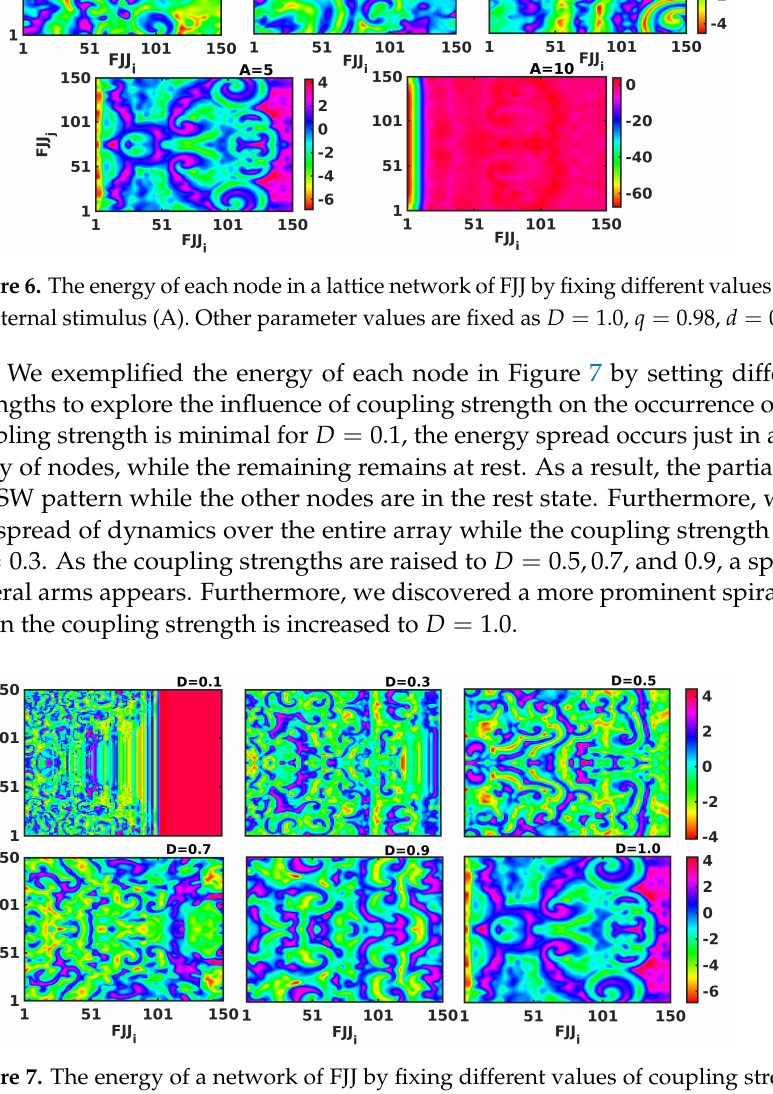
Figure 7. The energy of a network of FJJ by fixing different values of coupling strength (D). Other parameter values are defined as A = 5.0, q = 0.98, d = 0.31, and δ =